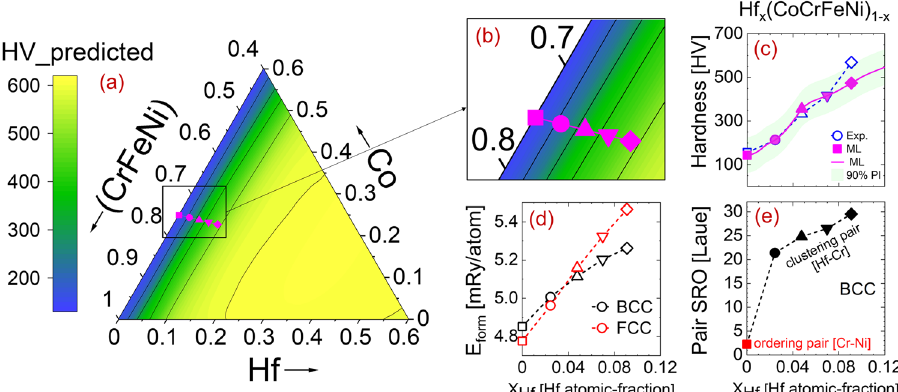
Fig. 4 ML predictions of hardness and corresponding DFT-predicted formation enthalpy and SRO. a Predicted hardness contours for Hf x Co y (CrFeNi) 1- x - y system, with b showing an expanded view of the compositions from experiments by Ma and Shek 40 . c Experimental and ML-predicted hardness for Hf x (CoCrFeNi) 1- x alloys with a 90% prediction-interval (PI). d DFT formation energies showing the relative stabilities of the BCC and FCC structures. e DFT SRO and the main ordering and clustering pairs